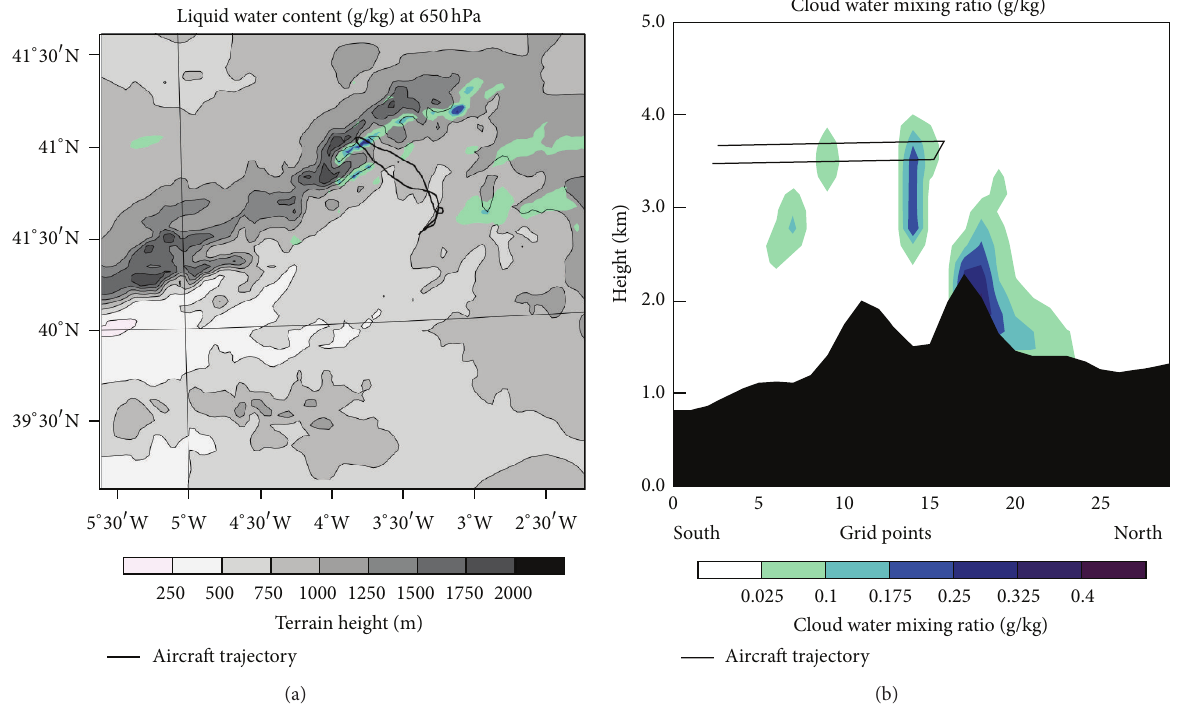
Figure 15: Liquid water content at 650 hPa (a) and on a cross section (b) of domain D03. Aircraft trajectory has been